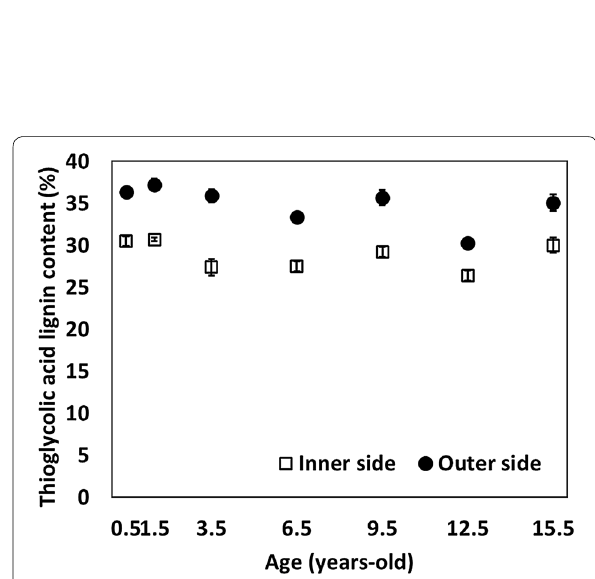
Fig. 5 Thioglycolic acid lignin content (%) of extraction-free bamboo